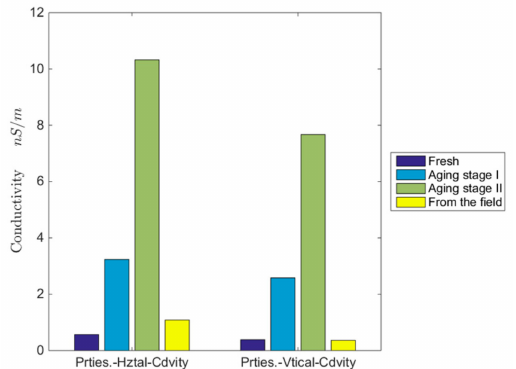
Figure 3. Conductivity measurements of fresh and aged mineral